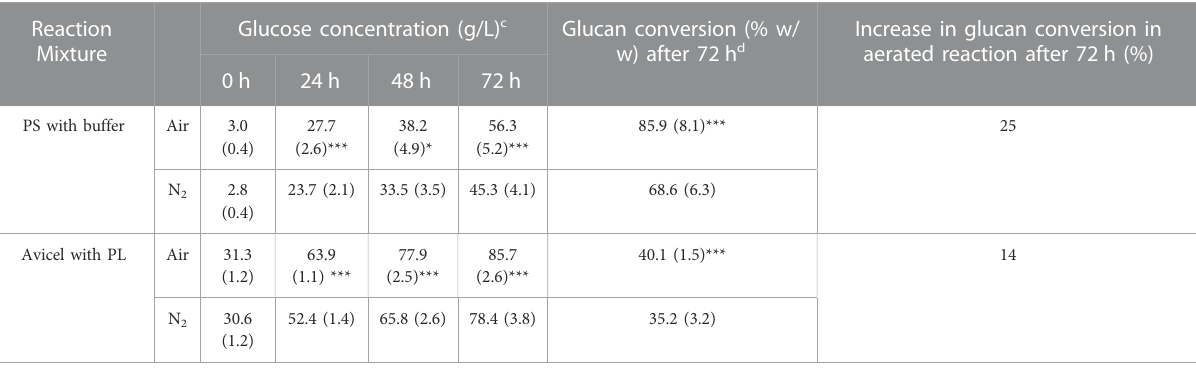
TABLE 3 Sugar yields from reaction mixtures with pretreated solids or pretreatment liquid. a,b Reaction Glucose concentration (g/L) c Glucan conversion (% w/ Mixture